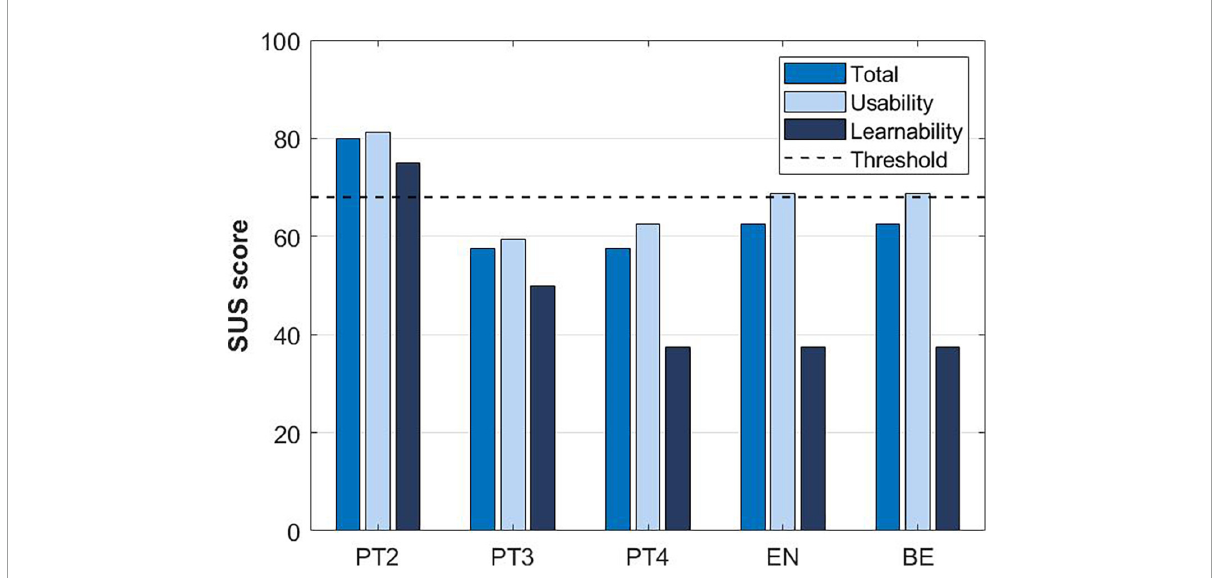
FIGURE6 The System Usability Scale (SUS) score and subscores reported by experts in stroke rehabilitation at